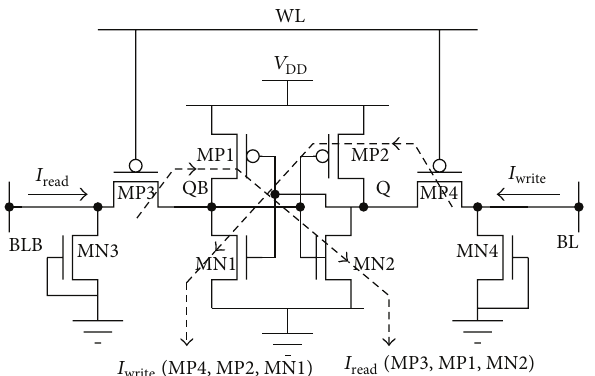
Figure 5: Read and write current flow through